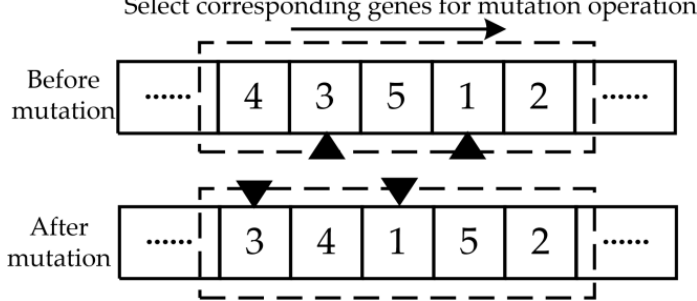
Figure 8. Mutation operation.